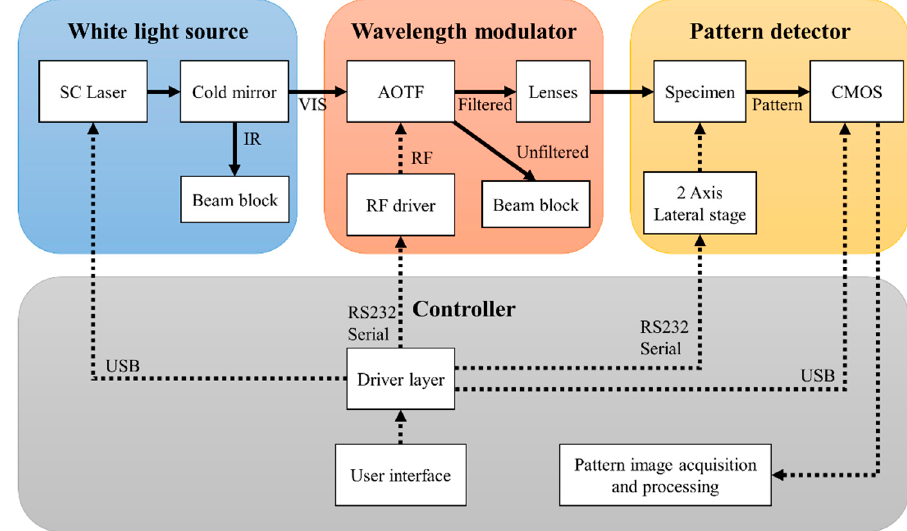
Figure 1. A schematic diagram of the hyperspectral elastic light-scatter phenotyping instrument (HESPI) and flow chart of the measurement. The main components of the instrument are illustrated in different colors. The solid line represents the beam path whereas the dotted line is the sequence of controls.